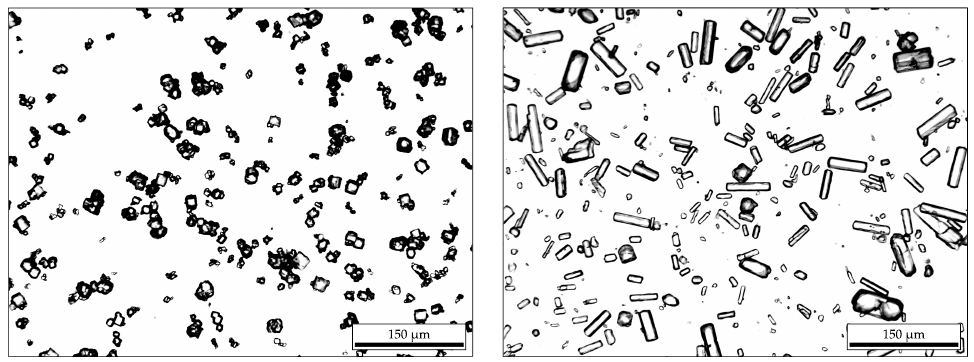
Figure 5. Light microscopy images of crystals produced in the process chamber. The ( left ) side of the figure shows isometric and the ( right ) side rod-shaped crystals.